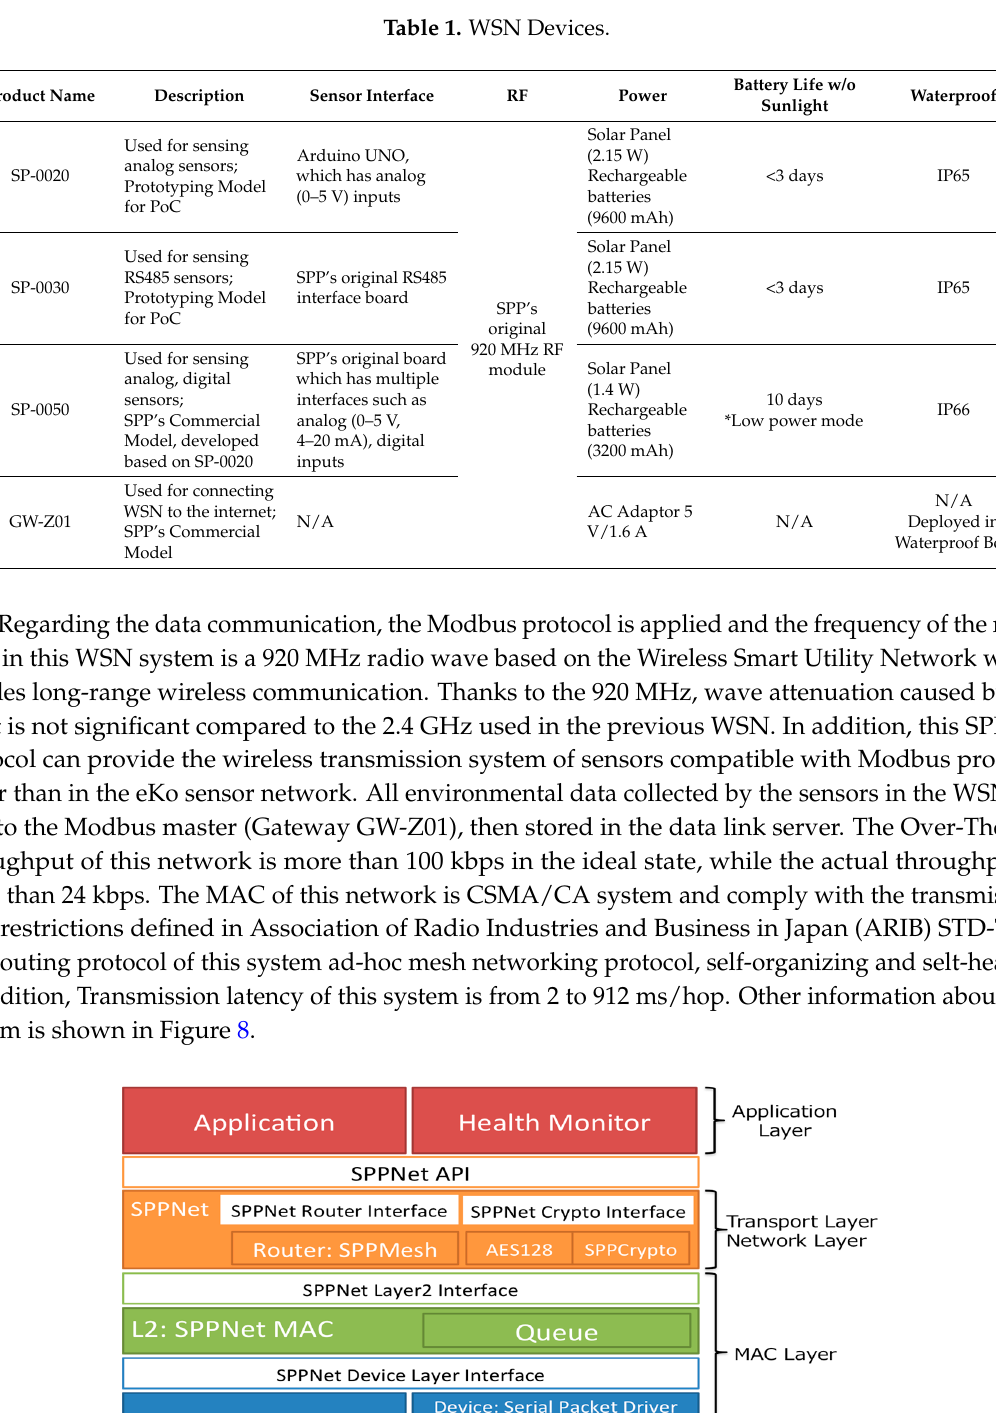
Table 1. WSN Devices.